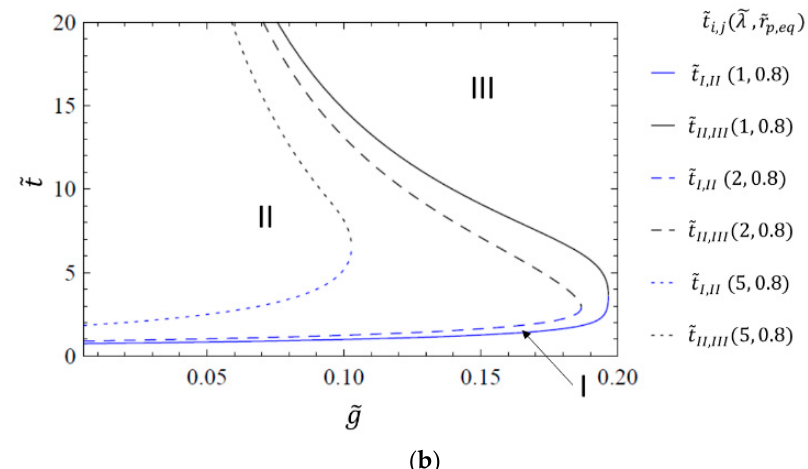
Figure 7. Transition times as a function of the gas transfer rate 𝑔(cid:3556) for the transfer coefficient model, for different values of the relaxation time 𝜆(cid:4634) ≤ 1 ( a ) and 𝜆(cid:4634) ≥ 1 ( b ) at a fixed value of 𝑟̃ (cid:3043),(cid:3032)(cid:3044) = 0.8 . The quantities in the legend are arranged as (𝜆(cid:4634),𝑟̃ (cid:3043),(cid:3032)(cid:3044) ) .